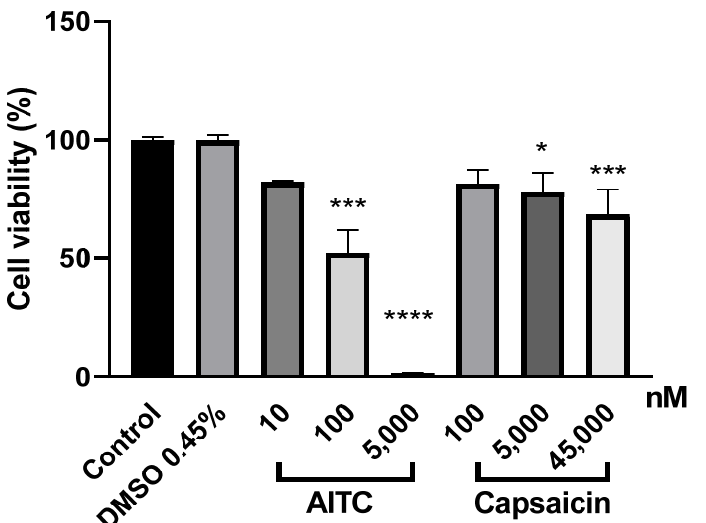
Figure 4. Effect of AITC and capsaicin in comparison with the solvent dimethyl sulfoxide (DMSO) on the viability of PE/CA-PJ41 cells, assessed by the CellTiter-Glo ® Luminescent Cell Viability Assay. Data show the average results of three independent experiments ± SEM. * p < 0.05, *** p < 0.005, **** p < 0.0001 (vs. control, one-way ANOVA, Dunnett’s post hoc test).